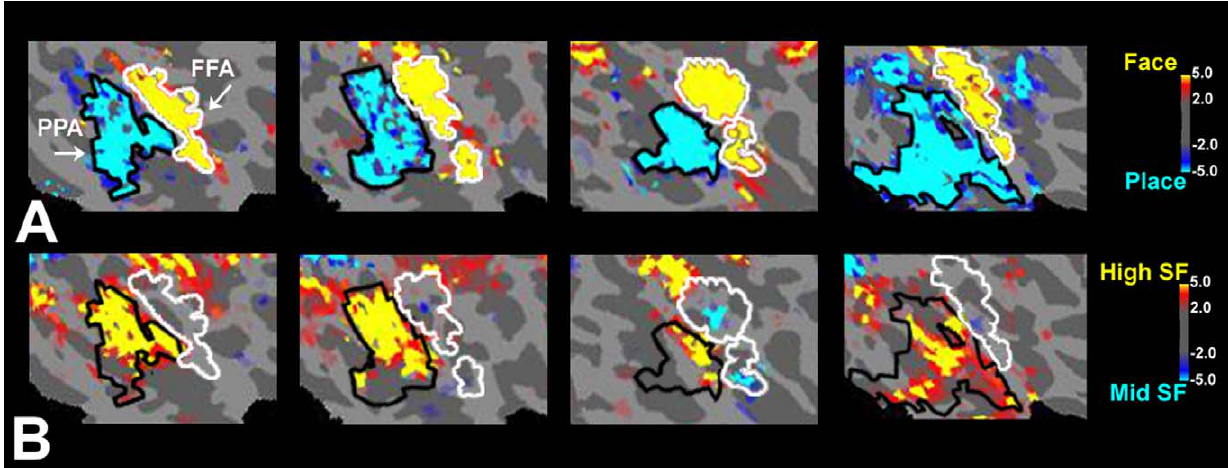
Figure 5. High-pass-filtered face images activate human PPA selectively. (A) The comparison of responses to normal faces versus normal places showed FFA and PPA in human ventral occipito-temporal cortex. Activation maps are displayed on magnified, flattened views of four hemispheres from four subjects. (B) The comparison of responses to high SF faces versus middle SF faces produced a selective activation to high SFs in PPA, even though the stimuli were faces instead of places. In some subjects, the reverse pattern of activation was found in the adjacent FFA. doi:10.1371/journal.pbio.1000608.g005 are crucial for survival in primate arboreal navigation (in reaching and grasping during brachiation [Figure 10], avoiding obstacles, etc.) or when detecting predators in visually complex surroundings.